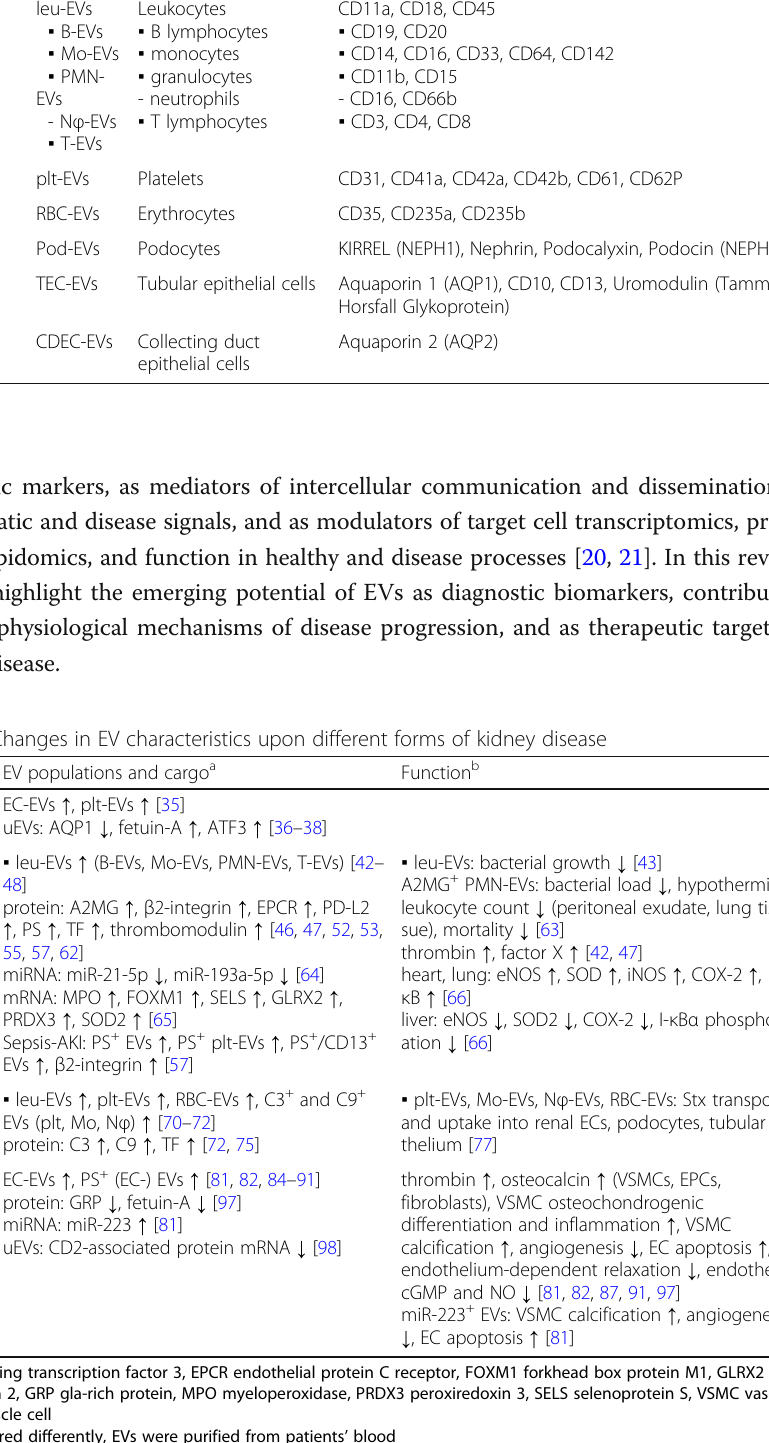
Table 2 Cellular lineages and characteristic surface markers of frequent circulating and urinary EVs Compartment EV Parent cell EV surface markers population